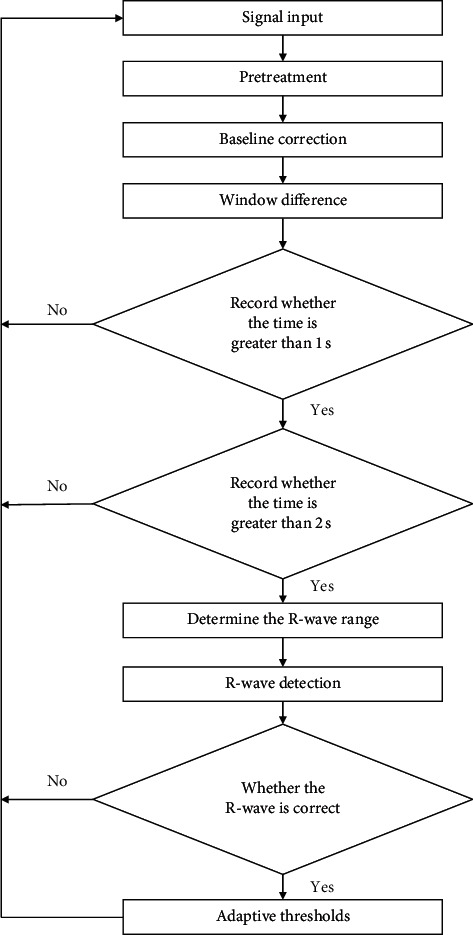
Algorithm flowchart.